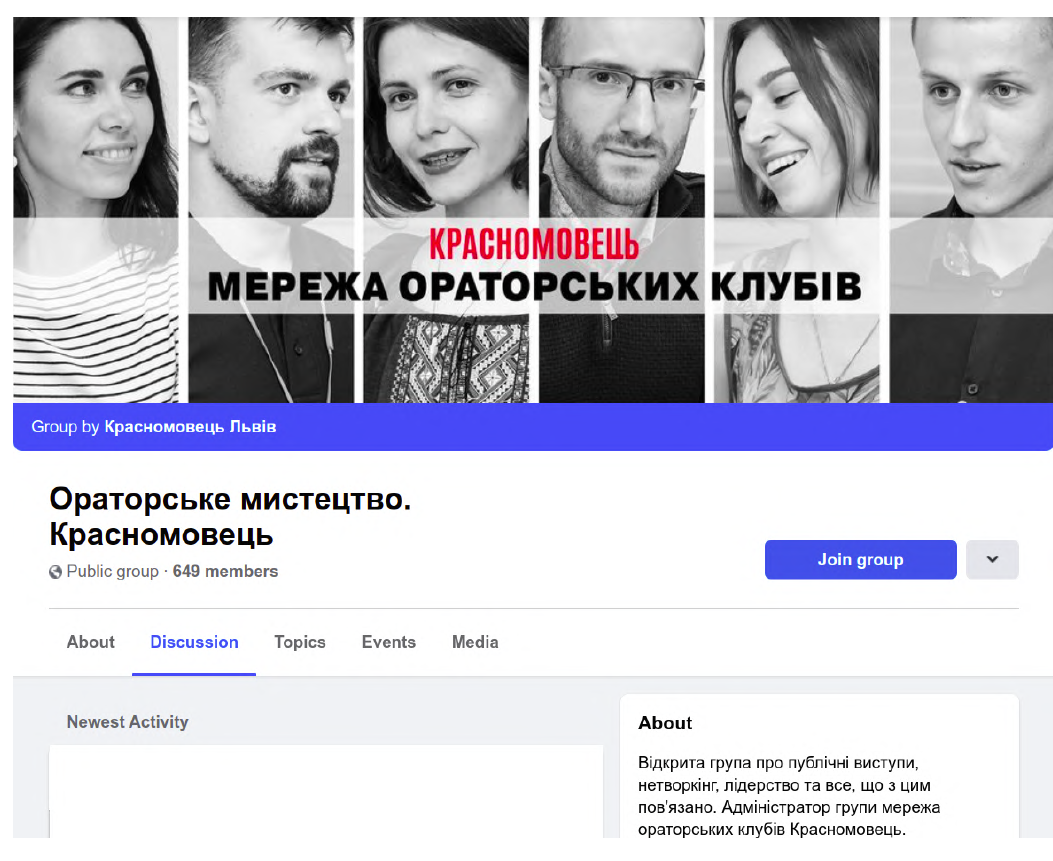
Figure 9: “Oratory community. Krasnomovets” on